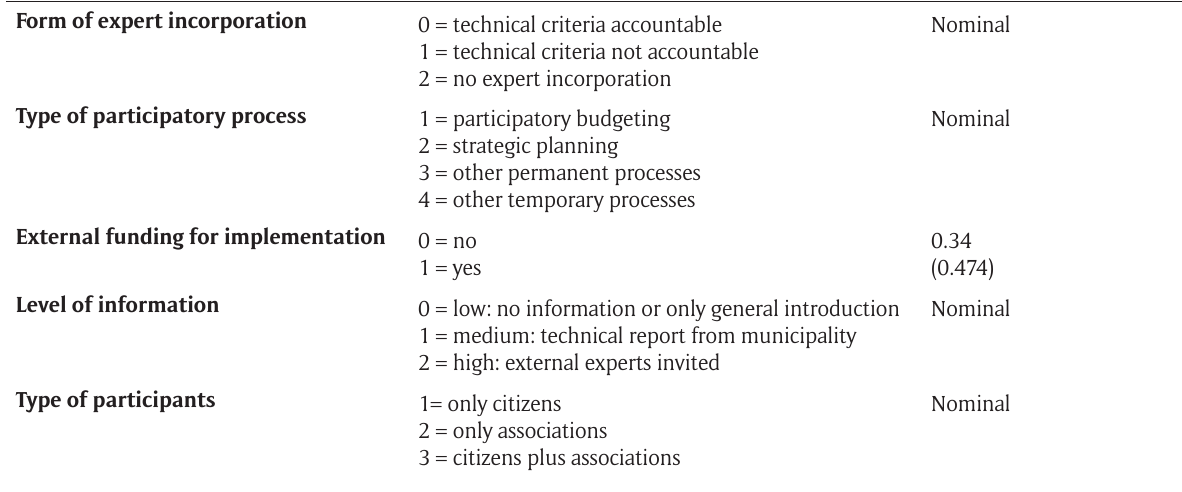
Table 2: Description of variables. Variables Operationalization: response